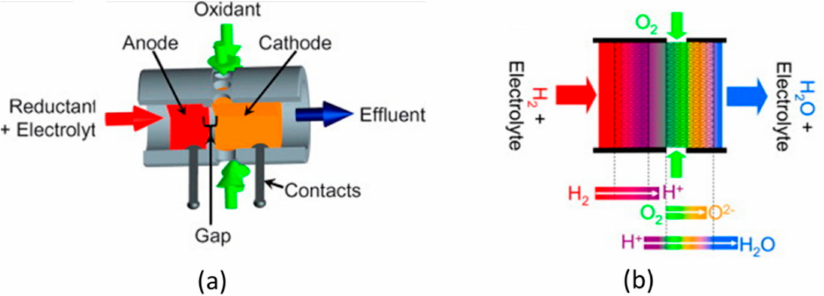
Figure 11. OFMMFC: ( a ) orthogonal flow design comprising porous electrodes separated by a gap, and ( b ) fuel (H 2 ) oxidation at anode to H + , and oxygen (O 2 ) reduction to O 2 − (reprinted from ref. [77]. Copyright 2008